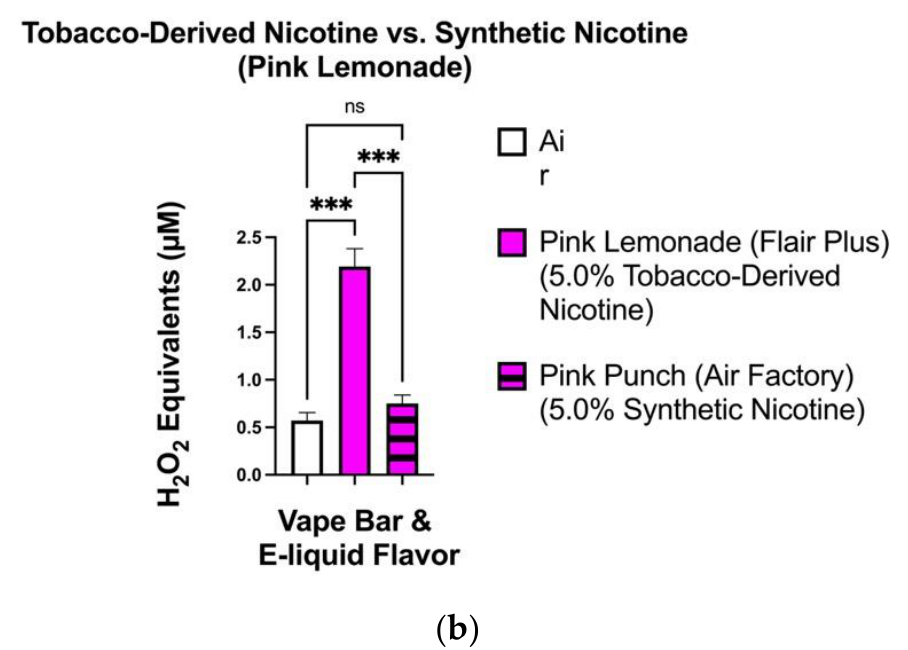
Figure 4. ROS generation among aerosols generated from tobacco ( a ) and drink flavored ( b ) TFN and tobacco-derived nicotine-containing vape-products. ROS levels within the generated aerosols from each individual tobacco and drink-flavored TFN e-liquid and tobacco-derived nicotine-containing vape-bar was measured via spectrofluorometry and quantified as H 2 O 2 equivalents. During analysis, the level of ROS generated from each individual vape-bar was compared to the ROS generated from the filtered air control. Data are represented as mean ± SEM, and significance was determined by one-way ANOVA. *** p < 0.001 versus air controls. ns is abbreviated for “Non-Significant” versus air-controls ( p > 0.05). Sample size (N) = 3 – 4.